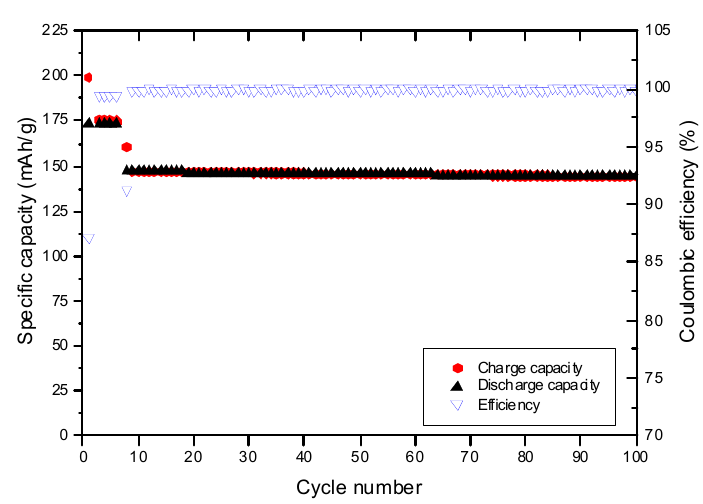
Figure 9. Cycling profile of NMC/graphite cell containing 1 M LiPF 6 in EMS:EA (1:1) + 4% FEC, in the voltage range from 3.0 and 4.3 V.